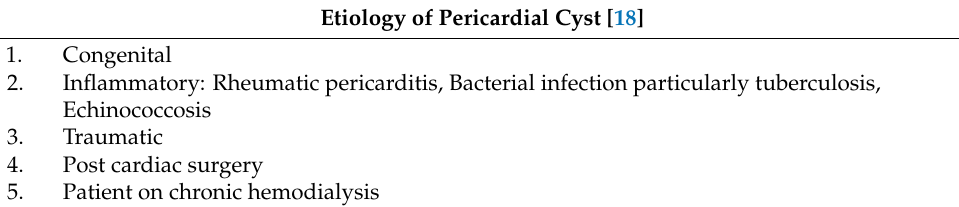
Table 1. Etiology of pericardial cysts according to previous